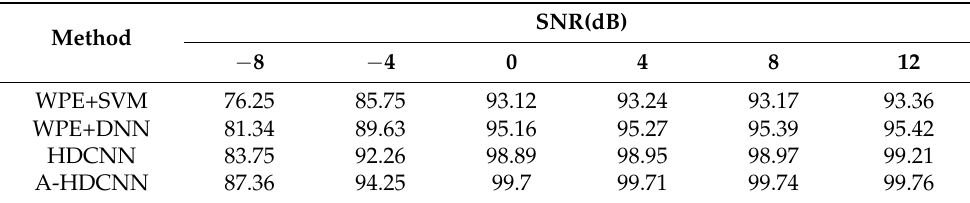
Figure 15. Comparative analysis of overall model diagnostic performance under different SNR environments. Table 9. Comparison of model diagnostic accuracy under different signal-to-noise ratio (SNR) environments.